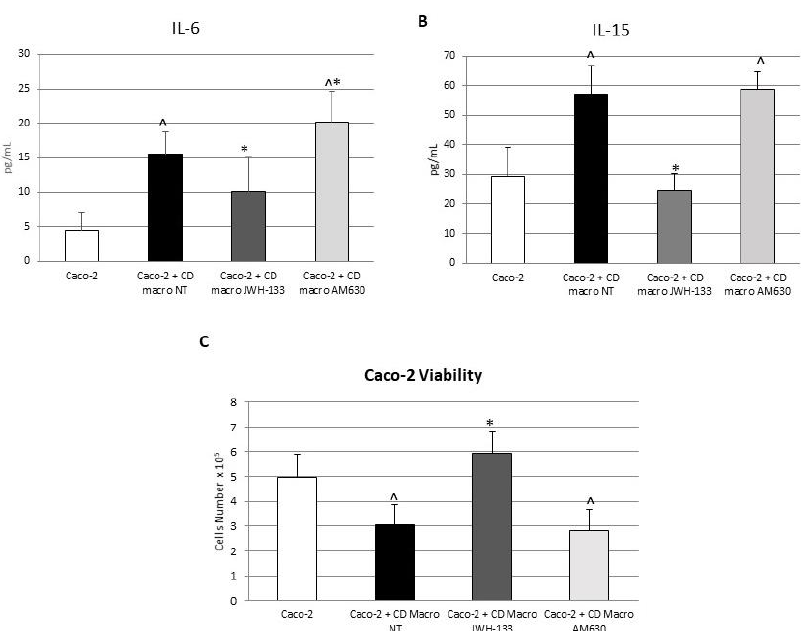
Figure 7. Effects of CB2 modulation on cytokines release by Caco-2 cells and on Caco-2 viability. ( A , B ) IL-6 and IL-15 concentrations (pg/mL) in Caco-2 cells alone and in coculture with CD macrophages isolated from 5 CD patients after 48 h JWH-133 [100 nM] and AM630 [10 µM] administration, determined by ELISA Assay. Histogram shows cytokine concentration as the mean ± S.D of independent experiments on each individual sample. The cytokine concentration was determined on a standard concentration curve according to the manufacturer’s instructions. ( C ) Caco-2 cell viability. The viability of Caco-2 cells cocultured with CD macrophages was estimated by a cytofluorimetric assay after 48 h treatment with JWH-133 [100 nM] and AM630 [10 µM]. A t-test has been used for statistical analysis. ˆ indicates p ≤ 0.05 compared to Caco-2; * indicates p ≤ 0.05 compared to Caco-2 + CD macrophages